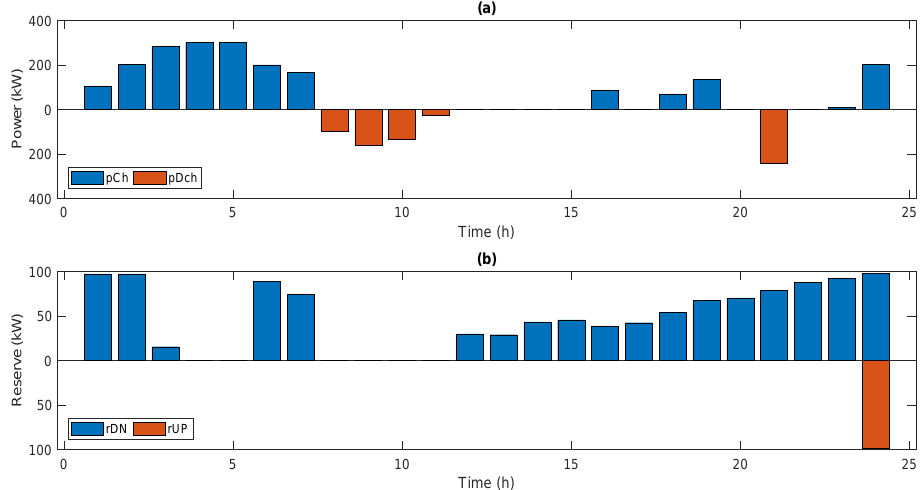
Figure 3. Power and reserve results: ( a ) Charging and discharging power; ( b ) downward and upward reserve.